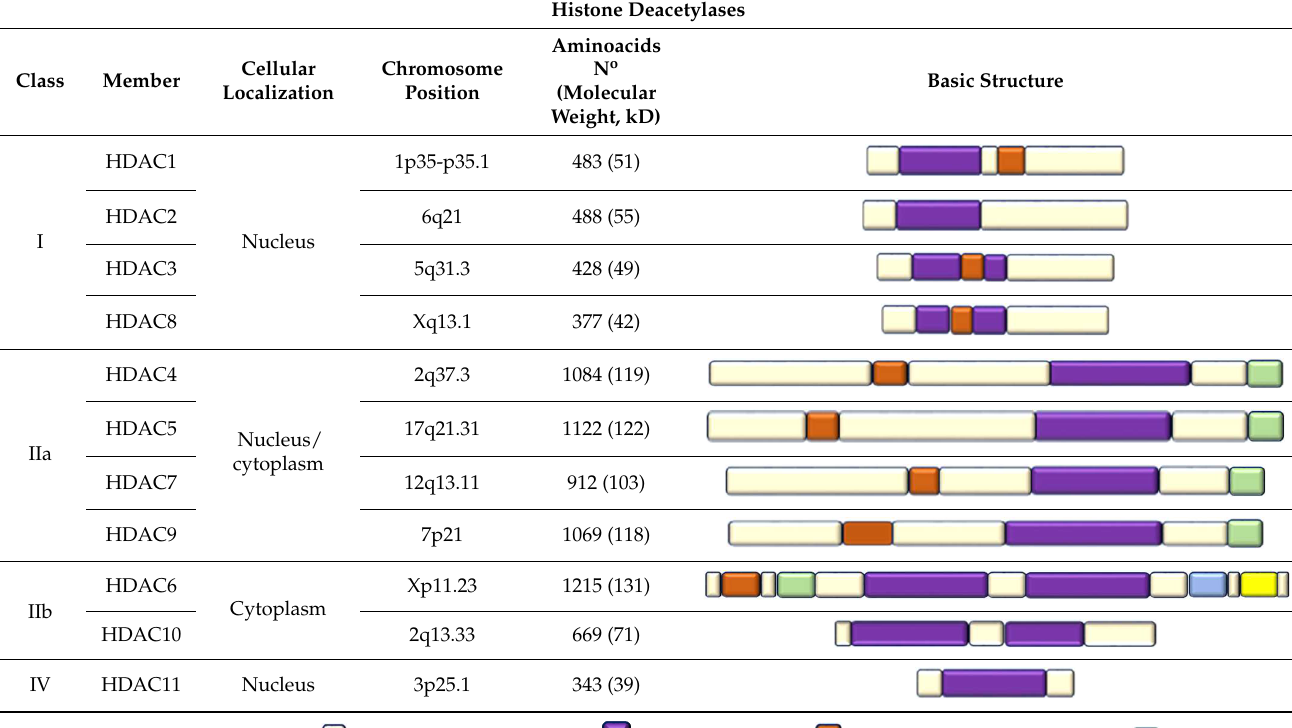
Table 1. Main cellular localization and basic molecular features of HDACs are indicated. Histone Deacetylases